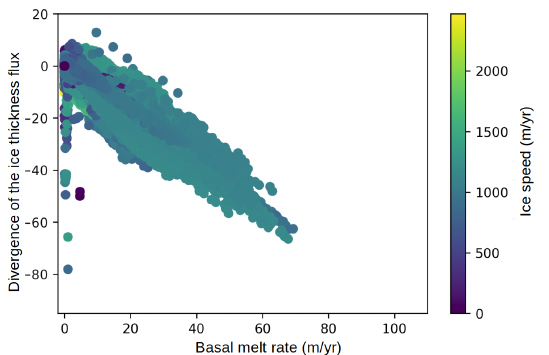
Figure 11. Scatter plot of the basal melt rate and the divergence of the ice shelf thickness flux in REF3mcpl, averaged over the 20-year simulation. The colour bar indicates the mean ice velocity.